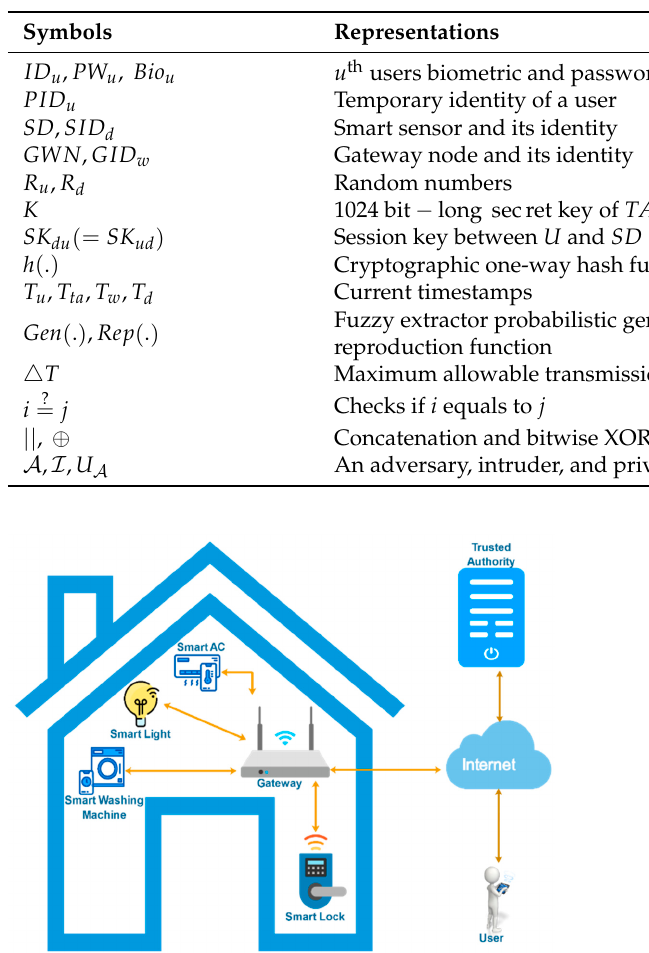
Table 1. Notations guide.